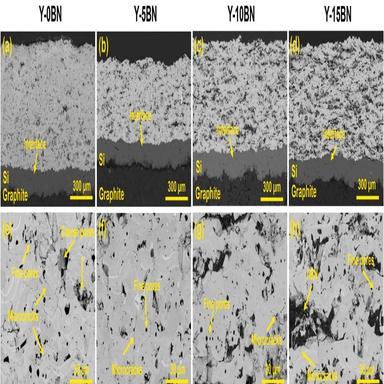
Cross-sectional morphologies of the Y–0BN (a, e), Y–5BN (b, f), Y–10BN (c, g), and Y–15BN (d, h) coatings.